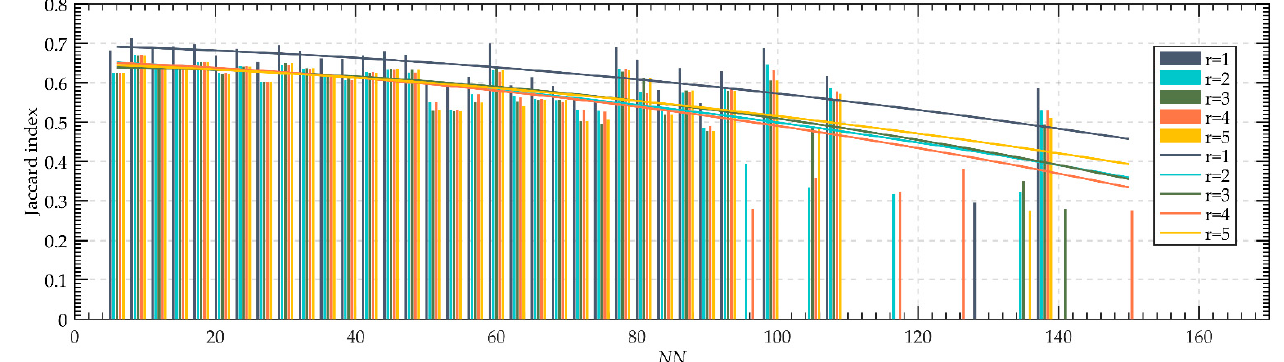
Figure 13. S for GRAN3SAT for different values of r . Jaccard Figure 13. S Jaccard for GRAN3SAT for different values of r . Table 17. S Jaccard under different relaxations and numbers of neurons ( NN ) . “-“ represents all the Table 17. S under different relaxations and numbers of neurons Jaccard final states of the GRAN3SAT model trapped in local minimum final states of the GRAN3SAT model trapped in local minimum solutions.